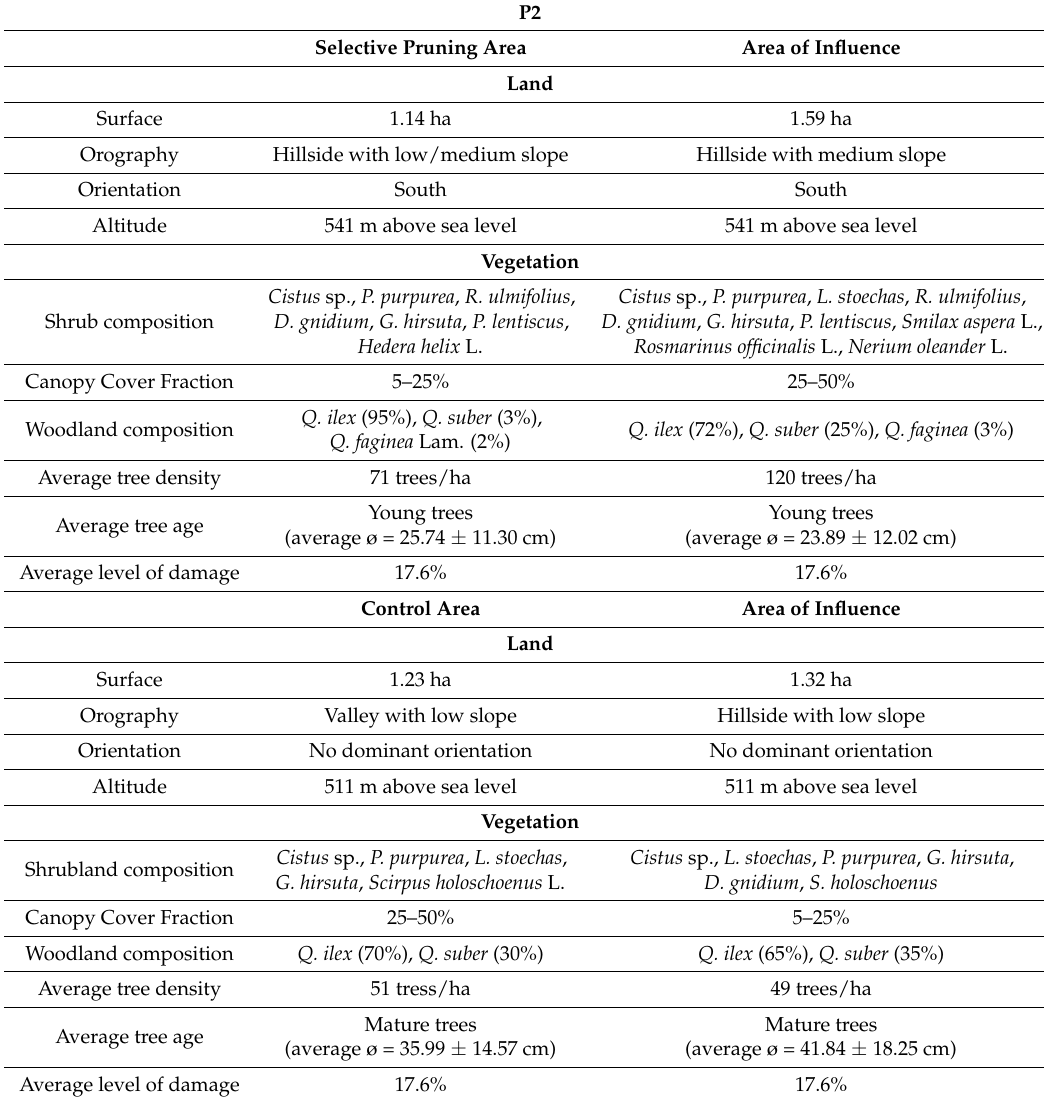
Table A2. Environmental features of each selected areas in P2 with specific regard to land (surface, orography, orientation, and altitude) and vegetation (vegetal composition and coverage, tree density, woodland age, and average level of damage by C. florentinus ) characteristics.